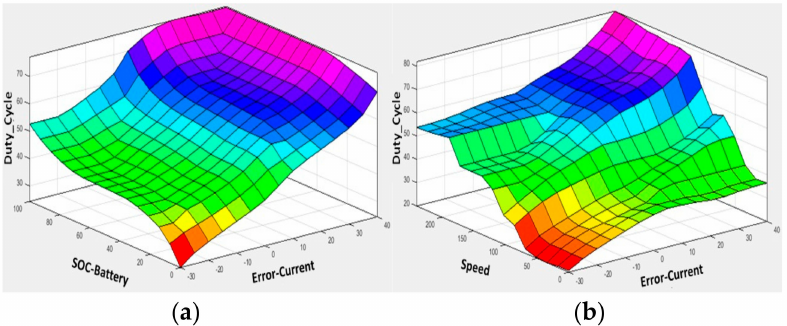
Figure 16. 3D outputs of proposed FLC: ( a ) 3D output of proposed FLC with SOC battery and error current as inputs ( b ) 3D output of proposed FLC with speed and error current as